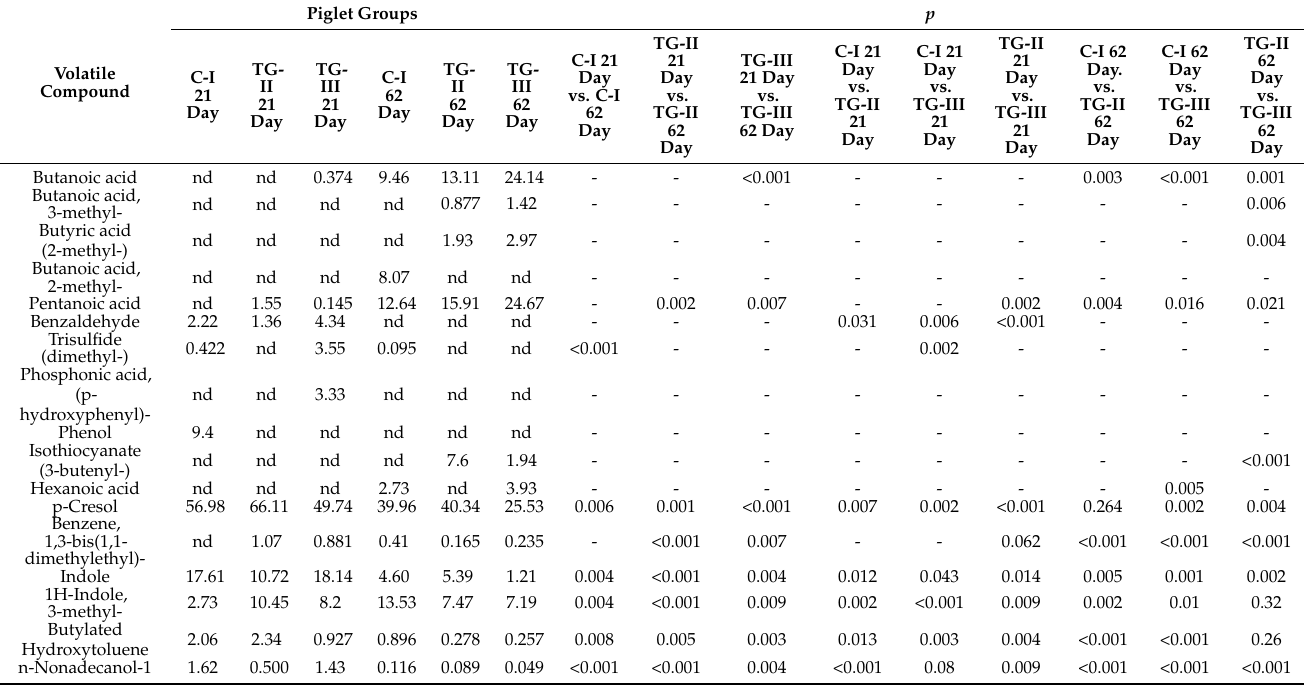
Table 7. Piglets’ faecal volatile compound profile (% of the total volatile compounds).